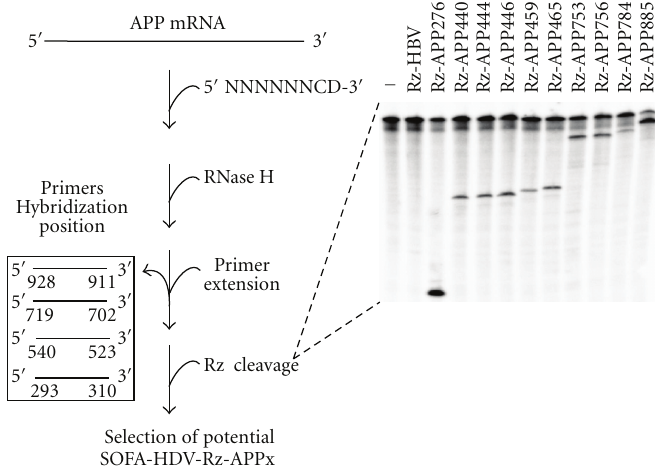
Figure 2: Selection of APP-SOFA-HDV ribozyme with the greatest potential cleavage. The left portion illustrates the strategy that was used to identify potential cleavage sites. APP mRNA was preincubated in the presence of a 7nt long randomized DNA oligonucleotide, and RNA/DNA heteroduplexes were hydrolyzed by RNase H. Accessible regions were then visualized by primer extension using one of the four 5 (cid:2) -end-labeled primers (in box) complementary to sequences retrieved in the first ∼ 900 nucleotides of the APP mRNA. Once the most accessible sites were identified, the appropriate SOFA-HDV ribozymes were synthesized and the cleavage activity was tested in vitro using 5 (cid:2) -end-labeled APP mRNA. A typical autoradiogram of a resulting PAGE is indicated in the right panel. The number of each Rz indicates the cleavage position within the APP mRNA. The Rz-HBV, previously used for HBV RNA cleavage [15], served as an irrelevant Rz. “-” indicates a reaction without